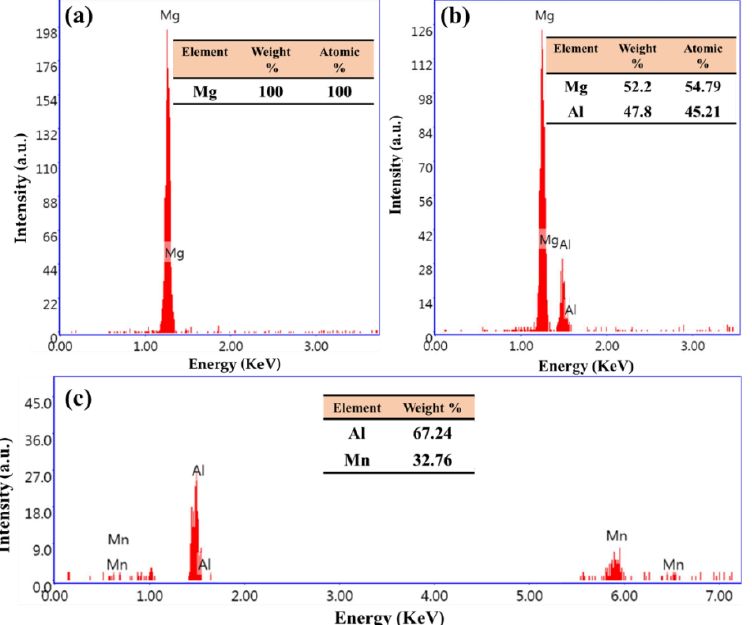
Figure 5. EDS analysis of the AZ91 matrix and the two intermetallics; ( a ) Mg matrix (spot 1 in Figure 4), ( b ) β -Mg 17 Al 12 (spot 2 in Figure 4), and ( c ) Al 4 Mn (spot 3 in Figure 4).